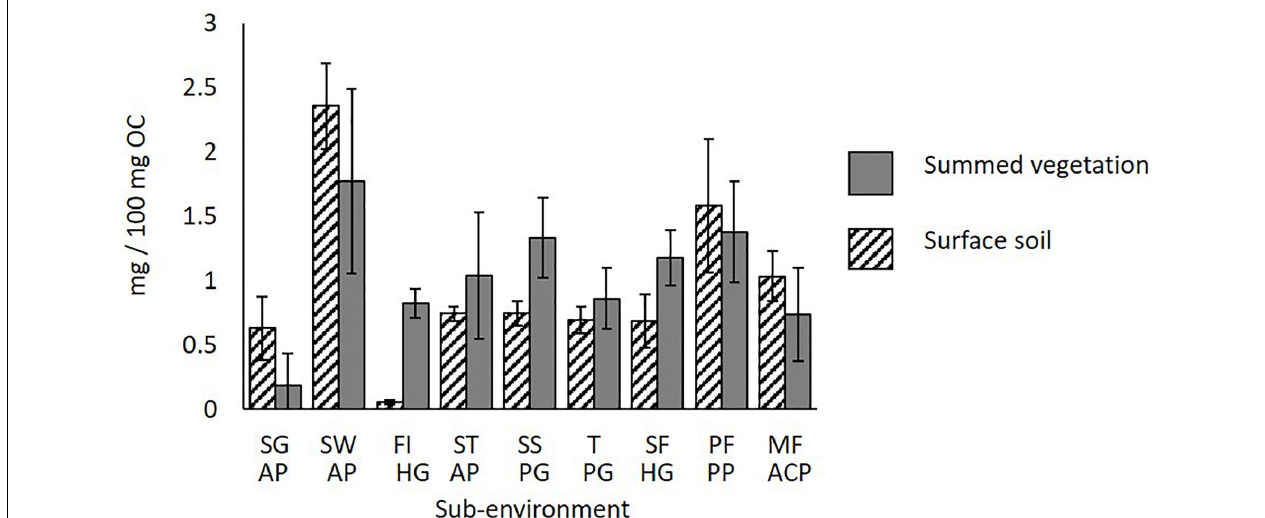
FIGURE 5 | 13 C-TMAH corrected (cid:51) values (mg/100 mg OC) for surface soils, and summed inputs = fresh shoot/leaf litter and wood litter across the transect. S.E. bars of 3 replicates shown. SG AP, Savannah Grassland Albic Plinthosol; SW AP, Savannah Woodland Albic Plinthosol; FI HG, Forest Island Humic Gleysol; ST AP, Savannah Tree Albic Plinthosol; SS PG, Savannah Swamp Plinthic Gleysol; T PG, Transition zone Plinthic Gleysol; SF HG, Swamp Forest Humic Gleysol; PF PP, Pisoplinthic Forest Pisoplinthic Plinthosol; MF ACP, Mixed Forest Acric